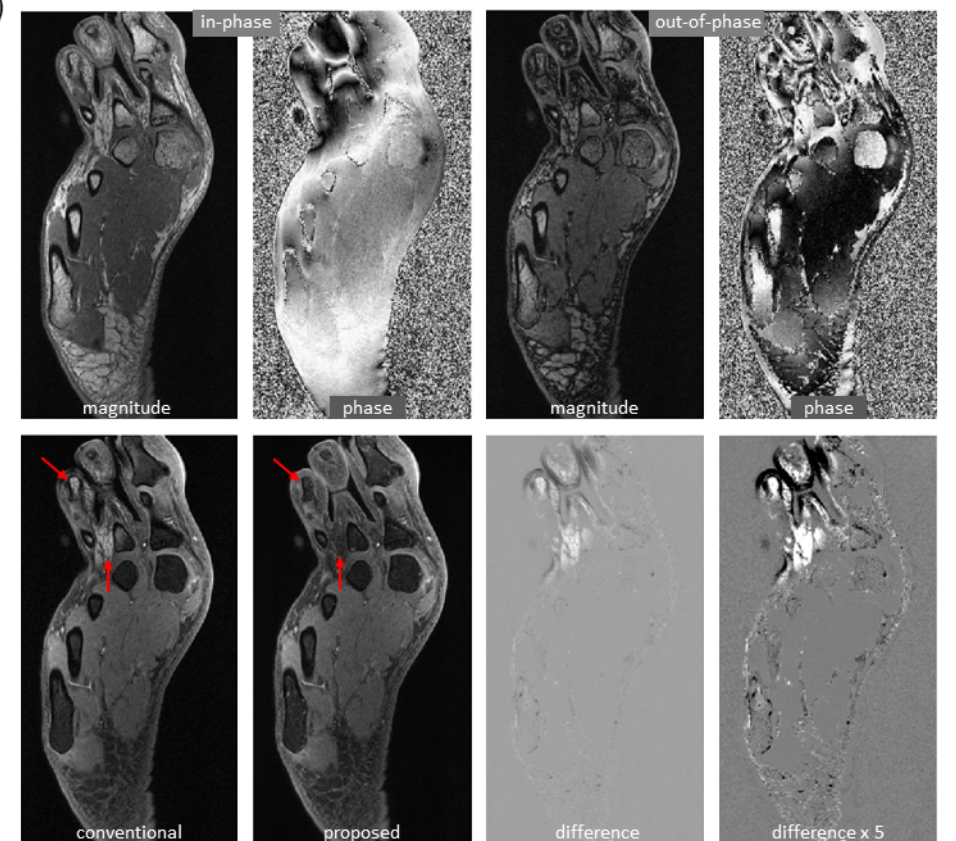
Figure 4. Mitigation of slight water/fat swaps. ( a ) Artifacts in an off-isocenter reference image of the knee (blue arrows), which were introduced by severe B 0 inhomogeneities, were automatically compensated in the predicted image. Here, tumor (red arrows) and adjacent nerve (green arrows) were well separated in the predicted image. ( b ) Water–fat separation was improved in the predicted image of the knee as compared to the reference image, which had regions of error (arrows). ( c ) More complete water–fat separation was observed in the predicted image of the arm, even if the deep learning model was trained with only knee images. ( d ) Some local water/fat swaps that appeared in the reference image of the foot did not occur in the predicted image. It is of note that the images ( c , d ) demonstrated the robustness of the approach to out-of-distribution data.